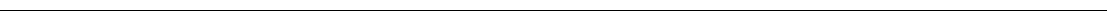
Fig. 6 TERRA accumulates in quiescence. a Schematic representation of the S. pombe telomeric transcripts. Subtelomeric region is shown as a gray line and telomeric repeats represented by dark gray triangles. Oligonucleotides used for RT-qPCR (oF1 and oR1, and random hexanucleotide NNNN), TERRA transcription start site (TSS), and HRS are indicated. b RNA from telomerase positive (WT) and ter1 Δ cells were extracted in proliferative (R) and in quiescent (D1 – D8) cells. RNA levels were determined by RT-qPCR using a random hexanucleotide primer followed by qPCR with speci fi c oligonucleotides for TERRA and control Fcp1. A control experiment was performed without reverse transcription step ( − RT). c TERRA fold enrichment was determined as the ratio of TERRA over Fcp1 RNA levels. Error bars indicate the SEM from three independent experiments; P- values are calculated from two-tailed t -test (* P = 0.0355; ** P = 0.001; **** P < 0.001). d Schematic representation of the S. pombe telomeric transcripts. The STE1 and Telo probes used for the northern blots are indicated by black and gray lines, respectively. The TERRA/ARIA and TERRA/ARRET/ α ARRET transcripts are detected with Telo and STE1 probes, respectively. e Northern blot analysis in telomerase positive (WT), rap1 Δ , and ter1 Δ cells. RNA was extracted in proliferative (R) and in quiescent (D1, D4, and D8) cells. The Northern blot was hybridized with a Telo, STE1 and U6 (loading control) probes. f Schematic representation of transcription in ter1 Δ quiescent cells. Duplication of TERRA TSS in STEEx may lead to accumulation of new